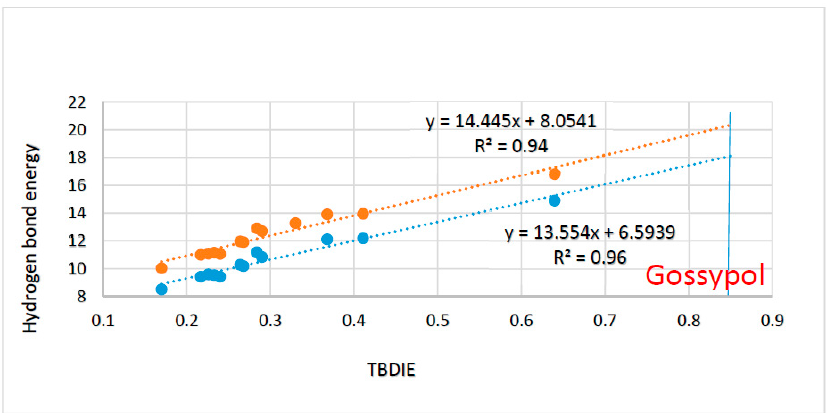
Figure 27. Plot of hydrogen bond energies vs. two-bond deuterium isotope effect on 13 C chemical shifts of o -hydroxyacyl aromatics. Plot of ‘hb and out’ hydrogen bond energies in kcal/mol. calculated either with MP2/6-311++G(d,p) or with B3LYP/6-311++G(d,p) vs. observed two-bond deuterium isotope effect (TBDIE) on 13 C chemical shifts in ppm. Top correlation line is B3LYP, bottom one is MP2. The observed TBDIE for gossypol is marked with the vertical blue line. Reprinted from Ref. [67].